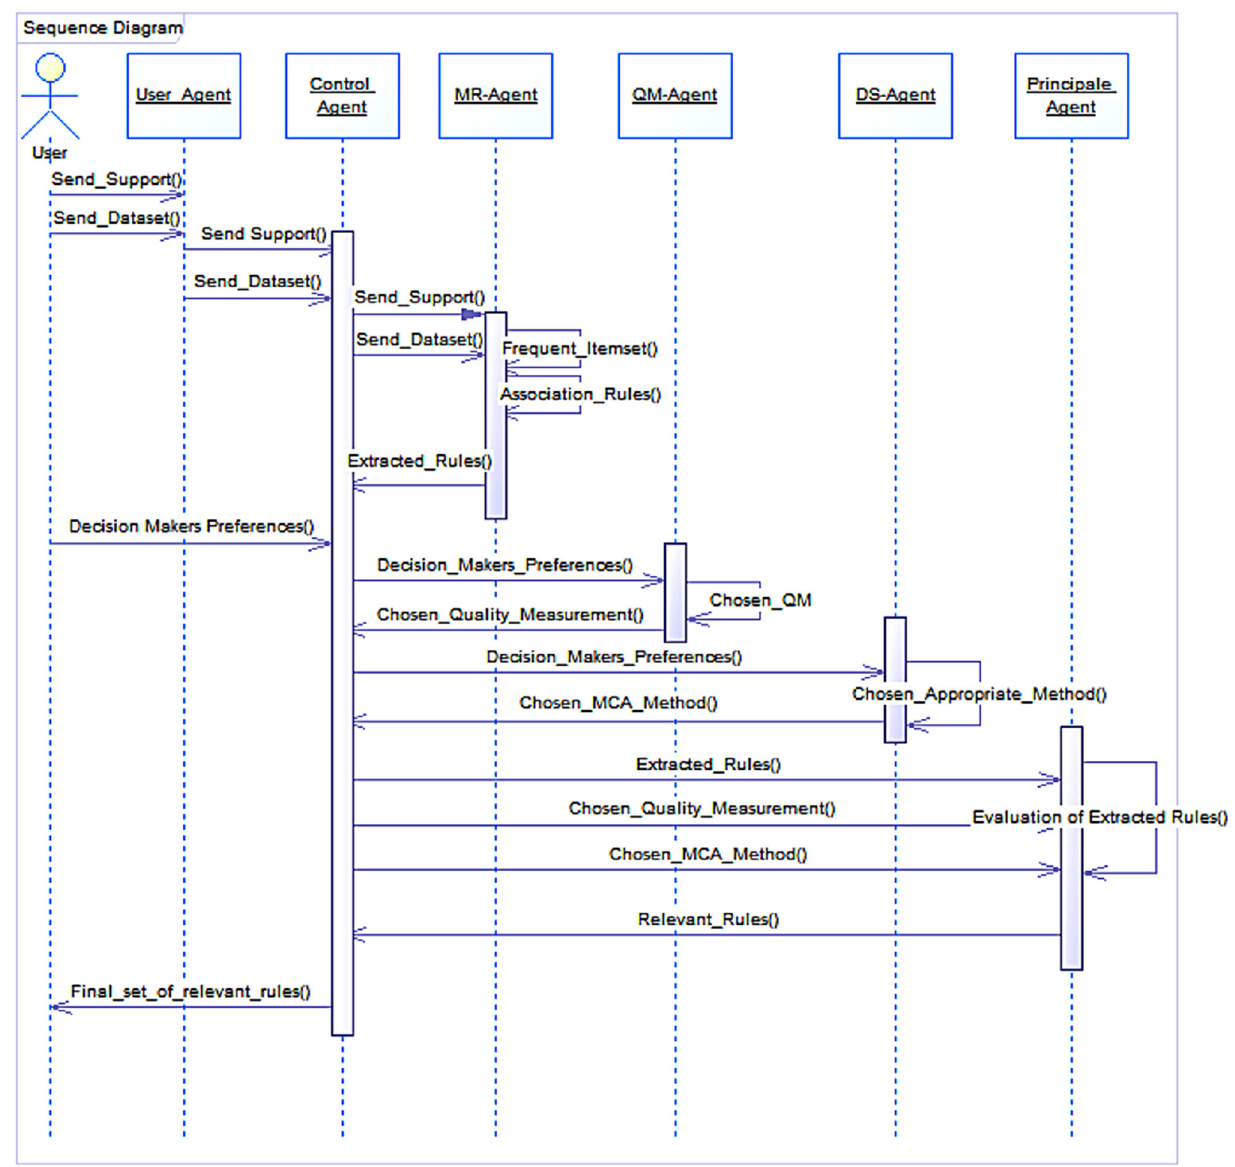
Fig. 6 The sequence diagram of the proposed